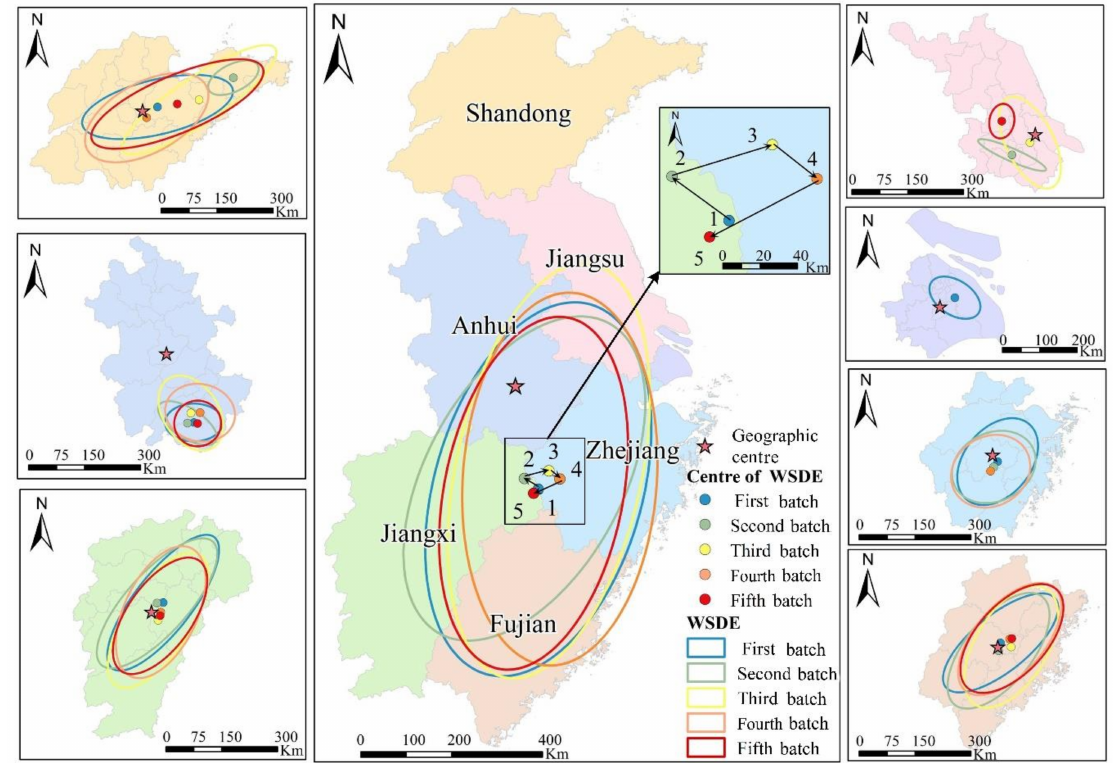
Figure 8. The WSDE and the center trajectories for eastern China and subordinate